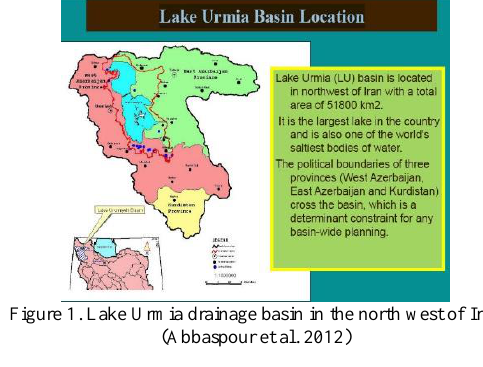
Figure 3. Urmia Lake’s water level using various data (UNEP and GEAS,